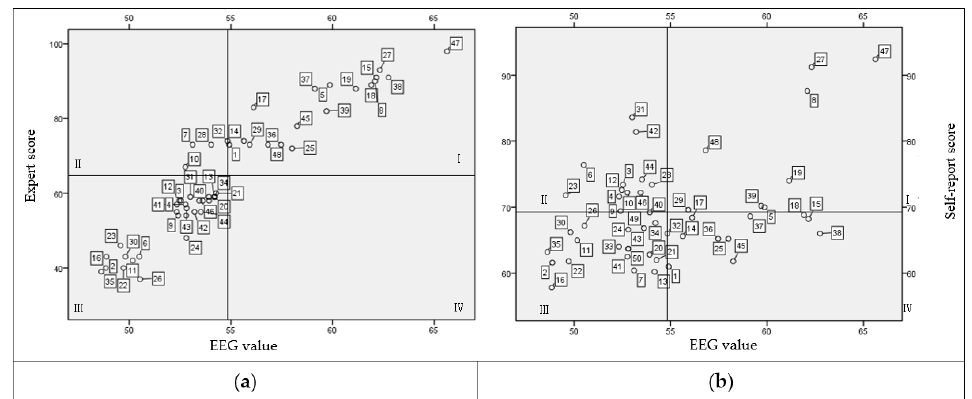
Figure 4. Four-quadrant chart of the results of the EEG, expert ( a ) and self-report ( b ) methods (No. 1–20 refer to A1–A20 spot, No. 21–38 indicate B1–B18 spot, and No. 39–50 mean C1–C12 spot. The reference lines are set at the mean values of the EEG, expert, and self-report scores.).